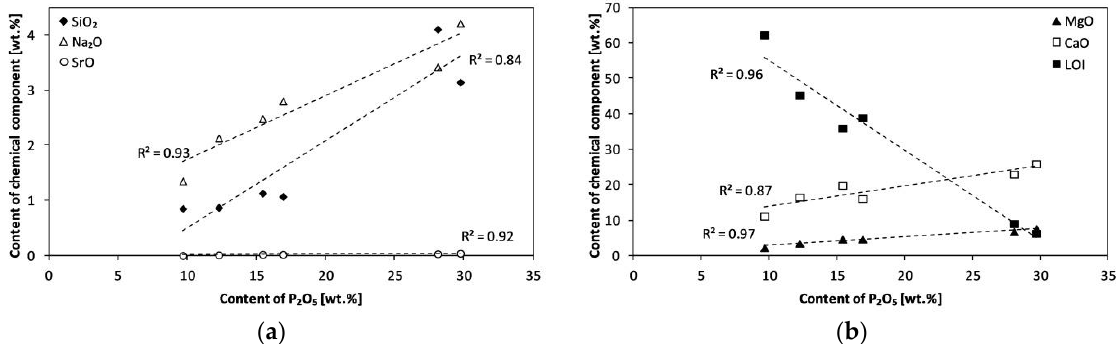
Figure 3. Dependence of the content of selected chemical components on the P 2 O 5 content in the studied ashes from poultry manure combustion. ( a ) Dependence of the content of SiO 2 , Na 2 O and SrO on the P 2 O 5 content. ( b ) Dependence of the content of MgO, CaO and LOI on the P 2 O 5 content.